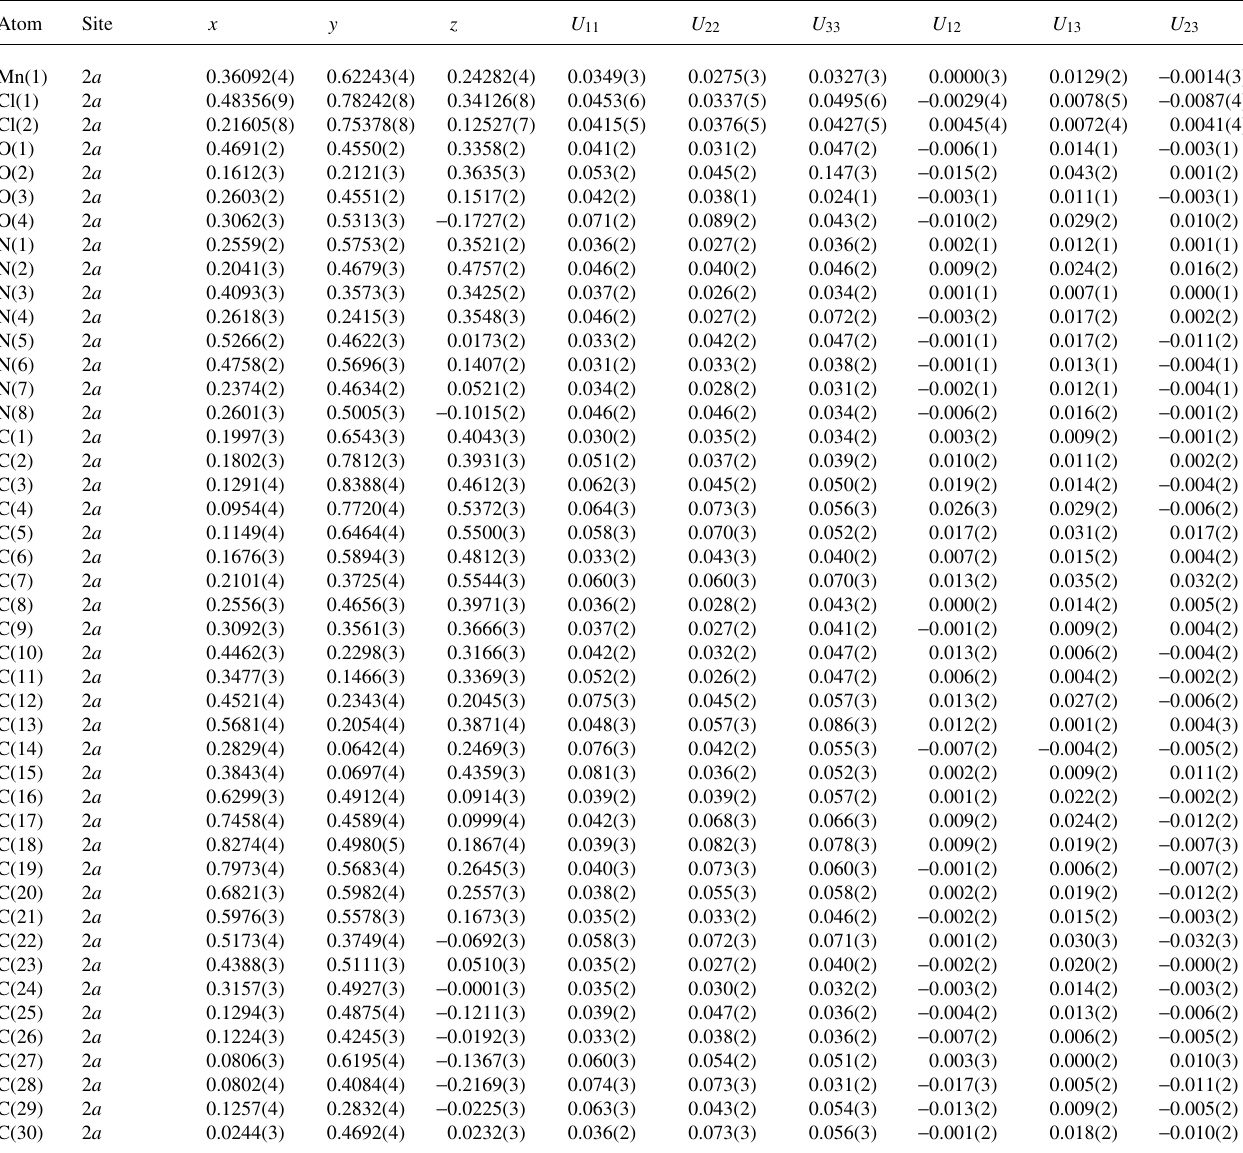
Table 3. Atomic coordinates and displacement parameters (in Å 2 )